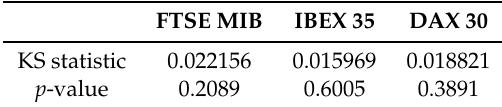
Table 3. Kolmogorov-Smirnov (KS) test